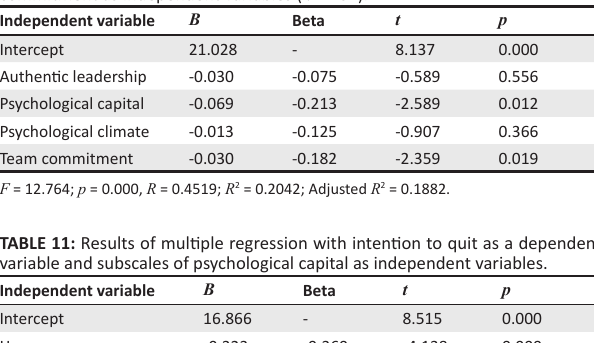
TABLE 10: Multiple regression with intention to quit as a dependent variable and authentic leadership, psychological capital, psychological climate and team commitment as independent variables ( n = 202).